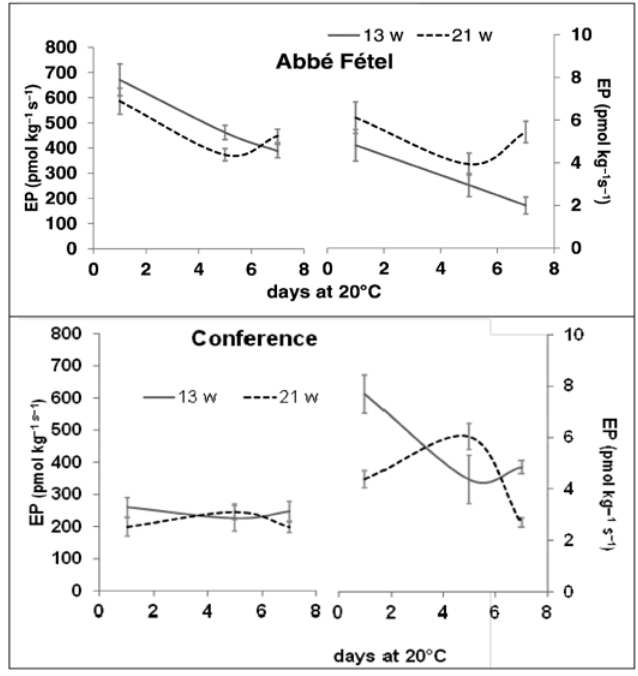
Fig. 3 - Ethylene production rate (EP) of control (left) and 1–MCP treated (right) ‘Abbé Fétel’ and ‘Conference’ pears during shelf life at 20°C after 13 and 21 weeks of storage. Bars refer to stan- dard error of the mean. Results of ANOVA analysis are reported in Table 3.